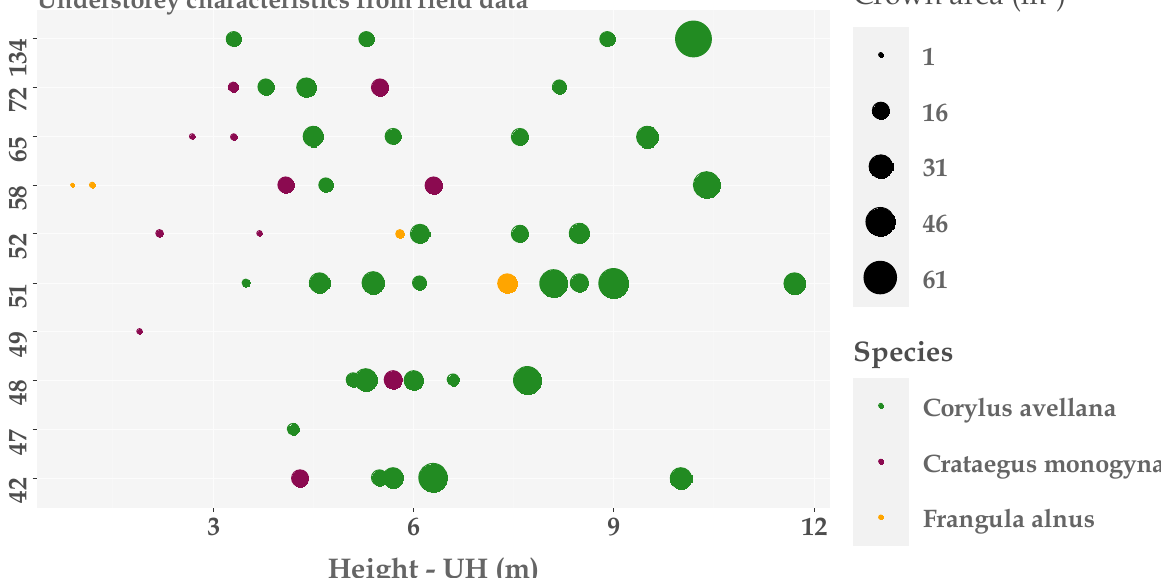
Figure A2 . Understorey characteristics (UH, crown area and shrub species) using field data at the plot level.